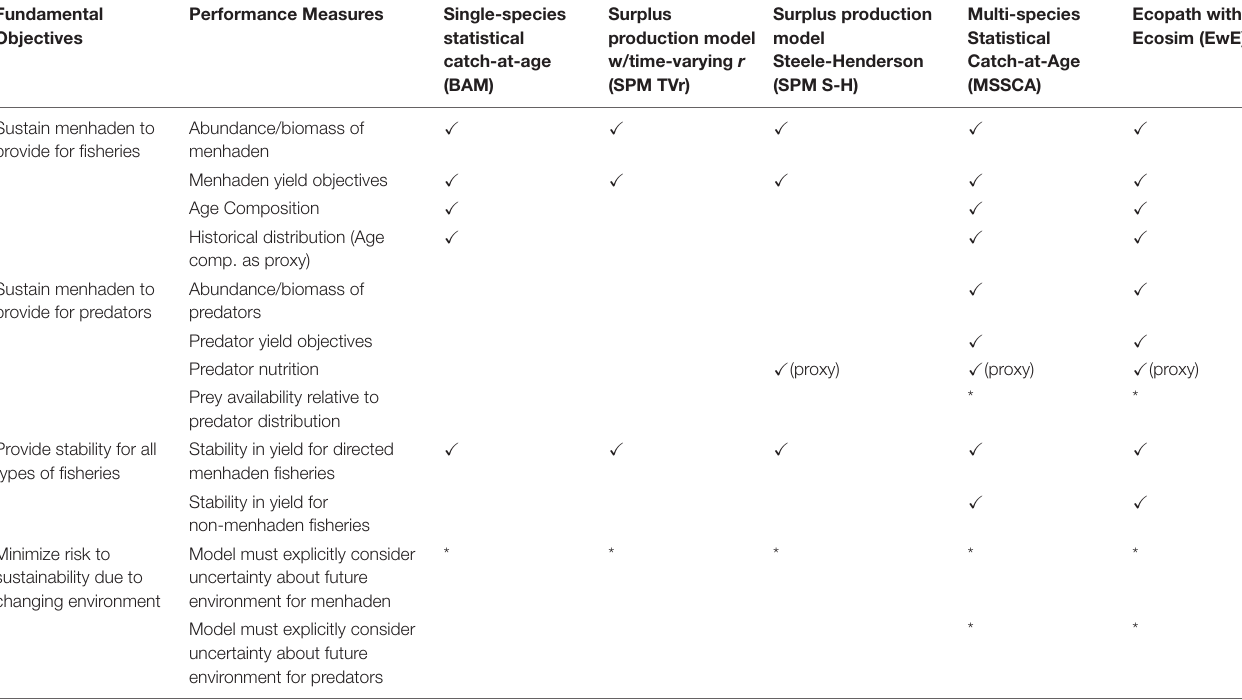
TABLE 5 | Fundamental ecosystem management objectives and their performance measures for Atlantic menhaden, and which ones each model is capable of meeting. Fundamental